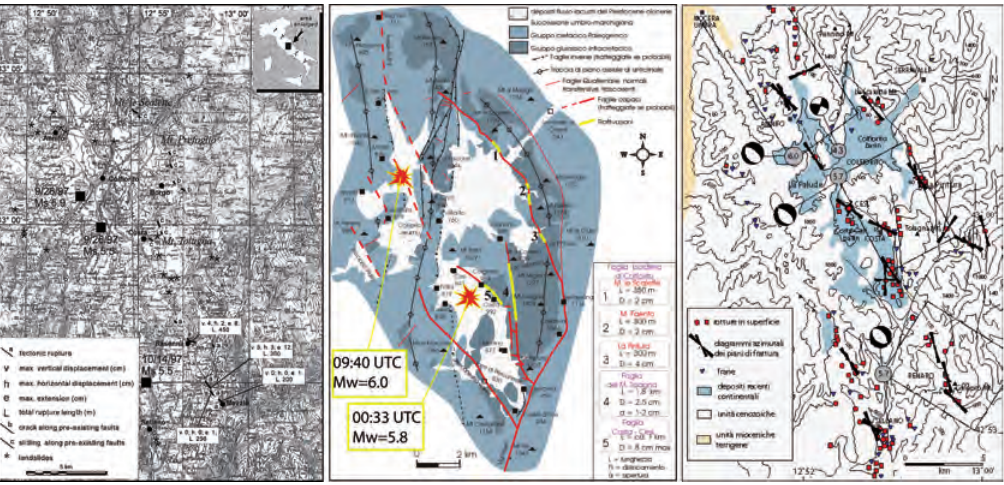
Fig. 3. First distributions of the surface ruptures published by different groups of surveyors. From left to right: Cello et al. (1998); Basili et al . (1998); Cinti et al .